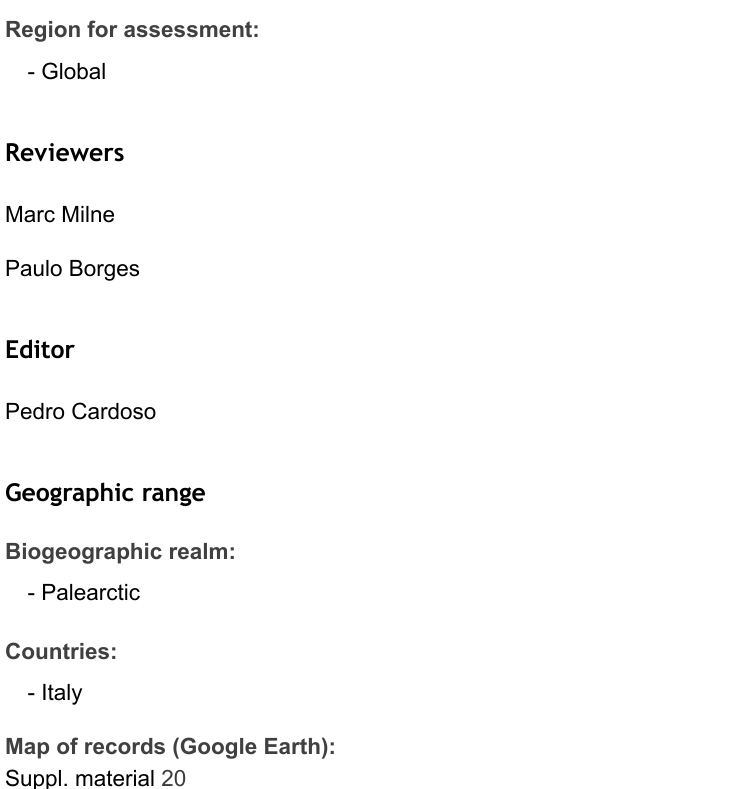
Basis (narrative) Multiple collection sites are recorded for this species. Therefore, it was possible to perform species distribution modelling to predict its potential range with confidence limits. See Methods for